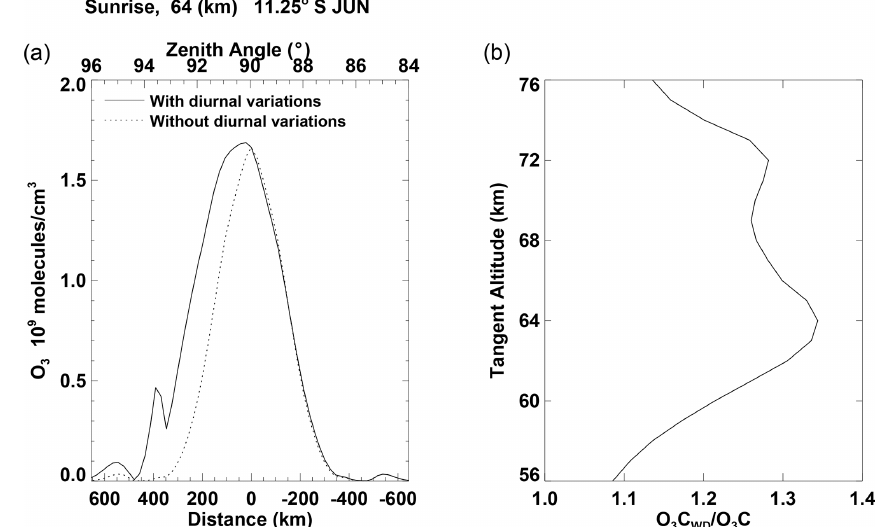
Figure 3. (a) O 3 concentration along the LOS for a tangent altitude of 64km at sunrise at 11.25 ◦ S latitude in June. Solid line shows O 3 with diurnal variations and the dotted line represents O 3 without diurnal variations. The x-axis represents the distance along the LOS relative to the tangent point with positive direction towards the instrument and negative direction towards the Sun. The upper x-axis shows the corresponding SZA. (b) Ratio of the O 3 column along the LOS with appropriate diurnal variations to the O 3 column without diurnal variations, plotted as a function of altitude at 11.25 ◦ S in June.